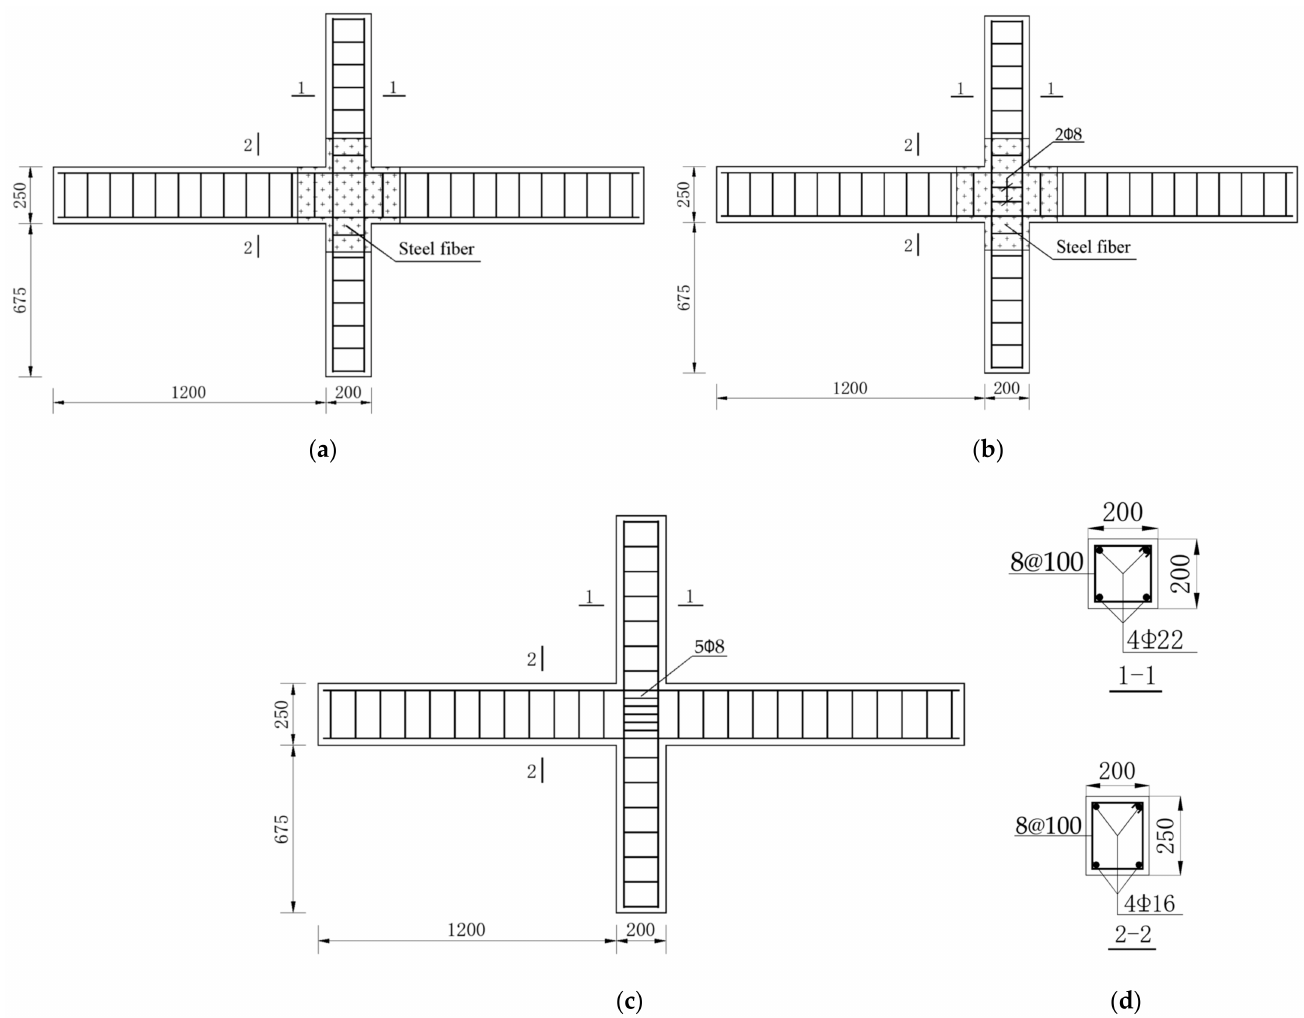
Figure 1. Geometry and reinforcement configuration of specimens: ( a ) BCJ1–0, BCJ1–1, BCJ1–2, BCJ3–2 and BCJ3–3; ( b ) BCJ2–2 and BCJ3–1; ( c ) BCJ5–1; ( d ) Reinforcement of specimen (units: